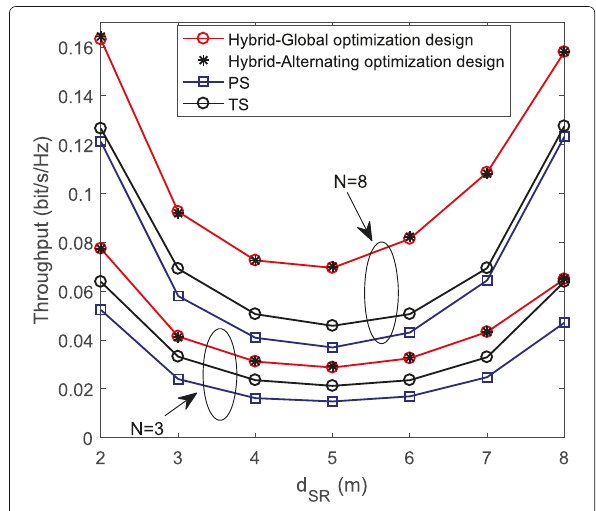
Fig. 8 Throughput performance of different protocols versus d SR , SNR = 20dB